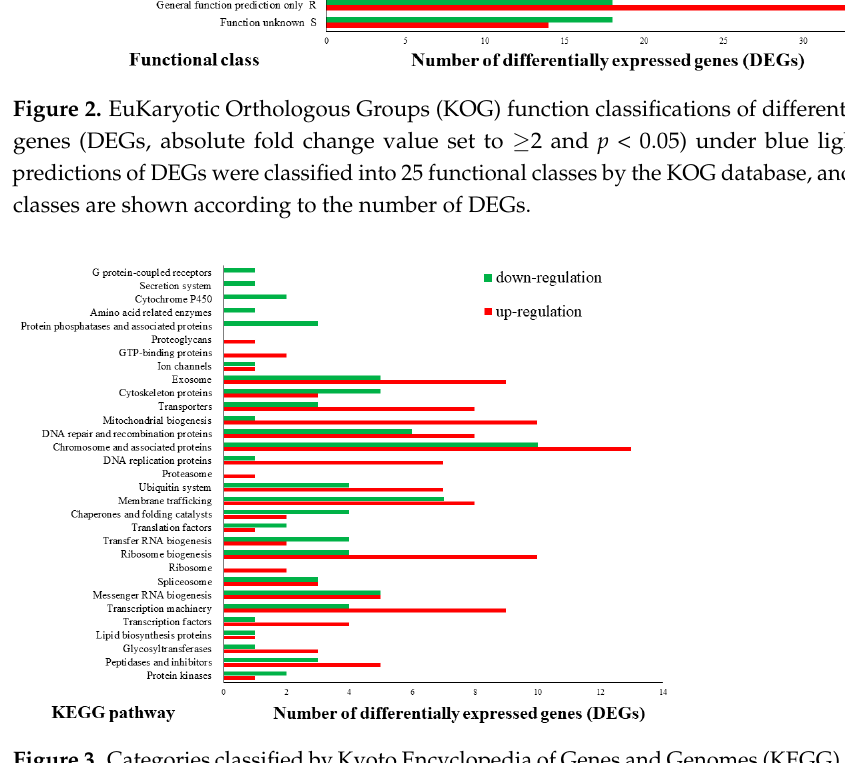
Figure 3. Categories classified by Kyoto Encyclopedia of Genes and Genomes (KEGG) of differentially expressed genes (DEGs, absolute fold change value set to ≥ 2 and p < 0.05) under blue light. Pathways are shown according to the number of DEGs.